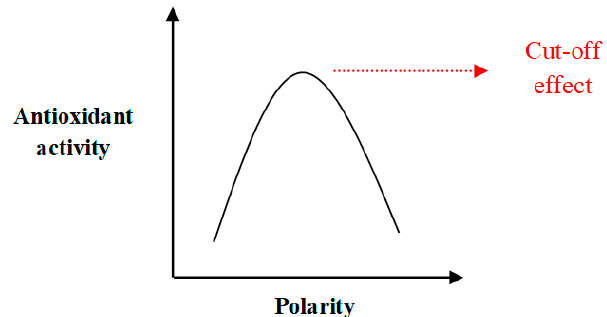
Figure 17. Cut-o ff e ff ect of antioxidant activity with respect to polarity (Adapted from Shahidi and Figure 17. Cut-off effect of antioxidant activity with respect to polarity (Adapted from Shahidi and Zhong Zhong [109]).